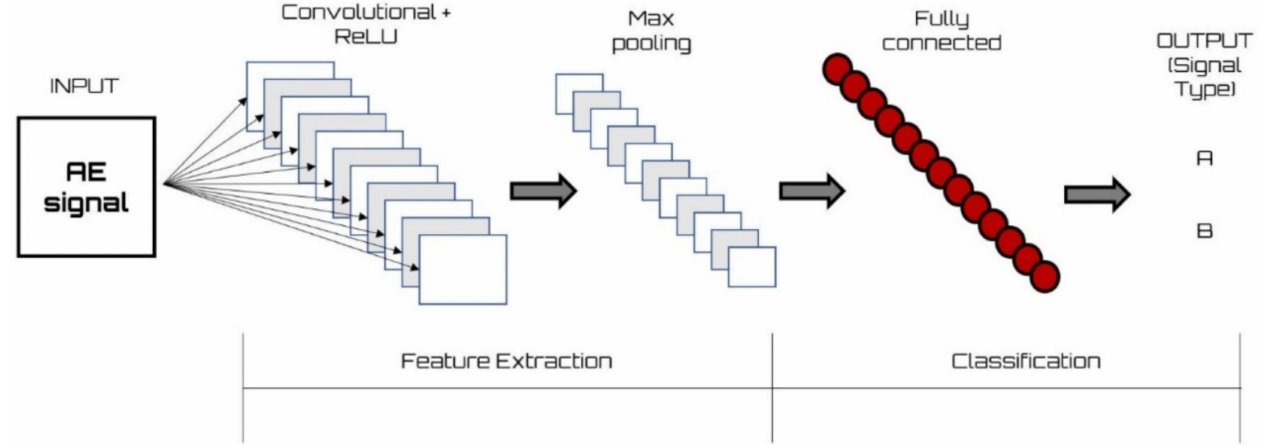
Figure 5. Typical CNN architecture: structure is divided into two sections, the first in which features composed of convolutional layers, ReLU, and Max pooling are extracted. Data classification section is instead made up of fully connected